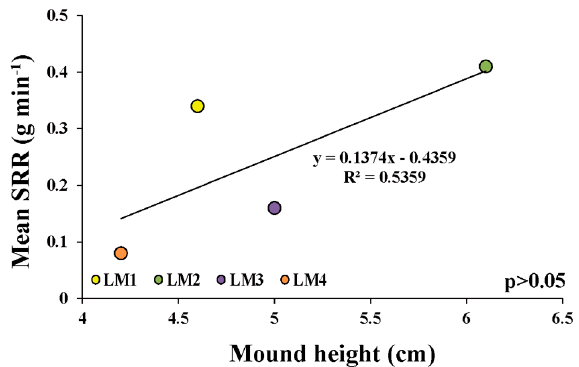
Figure 5. Correlation between ( a ) mean SRR and mean duration of submergence, and ( b ) mean SRR and elevation over the study period. Yellow, green, purple, and orange circles represent LM1, LM2, LM3, and LM4, respectively.